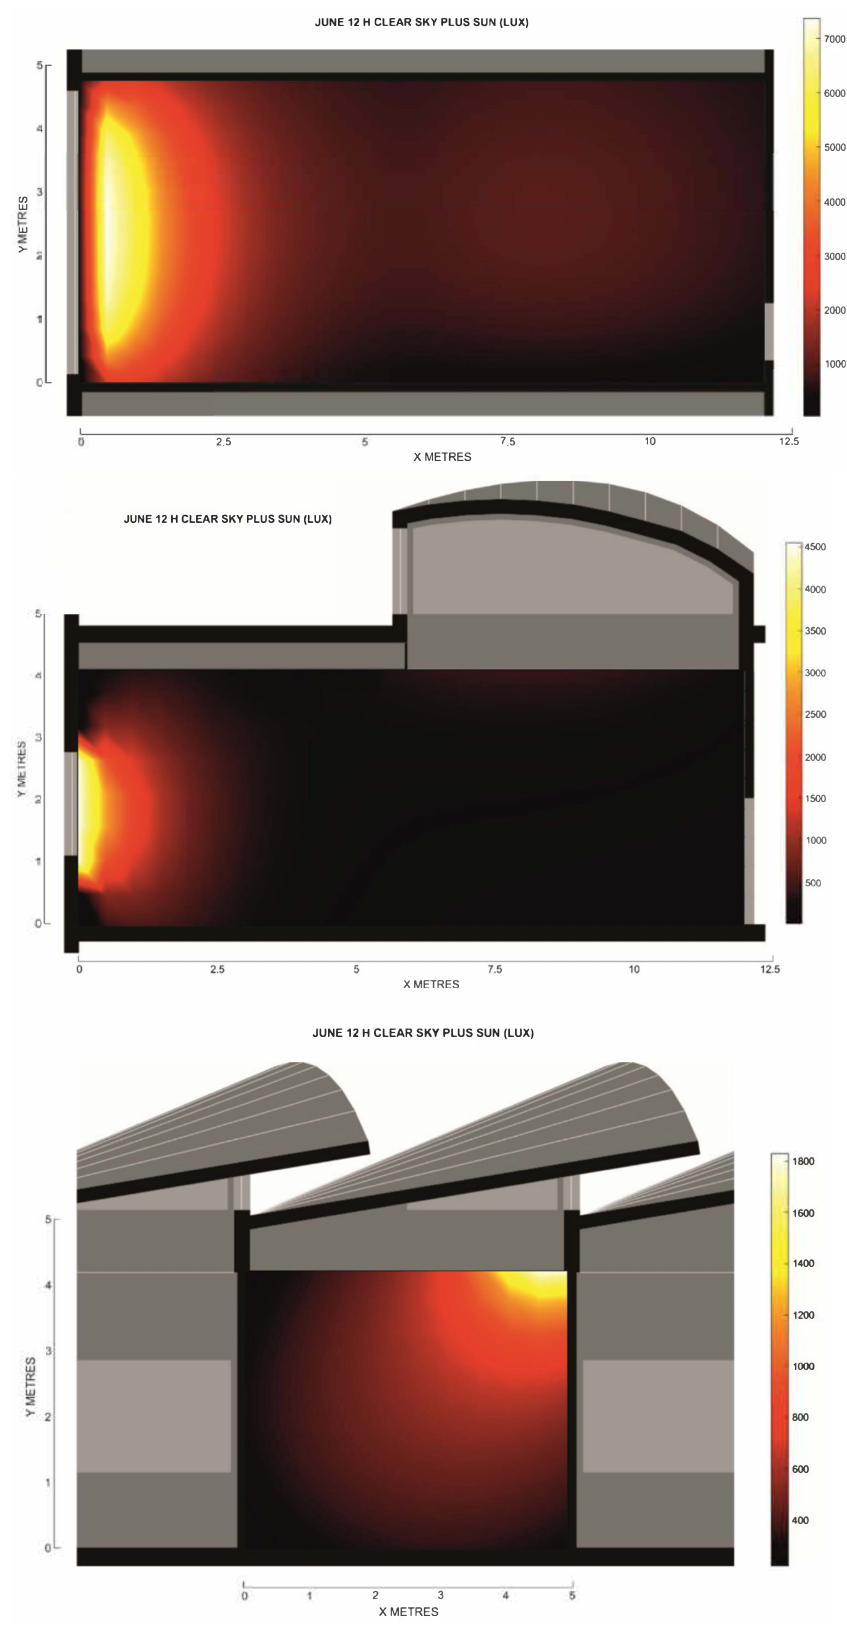
Figure 10. The horizontal and vertical illuminance distribution in an office. June 12:00 h solar time, clear sky plus sun. Values in lux. Source: the